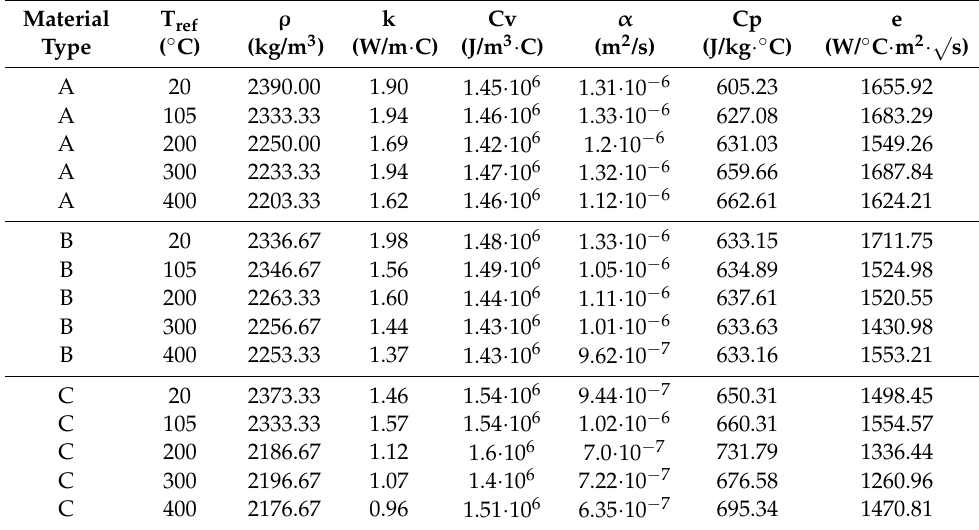
Table 7. Thermal properties of the concrete mix